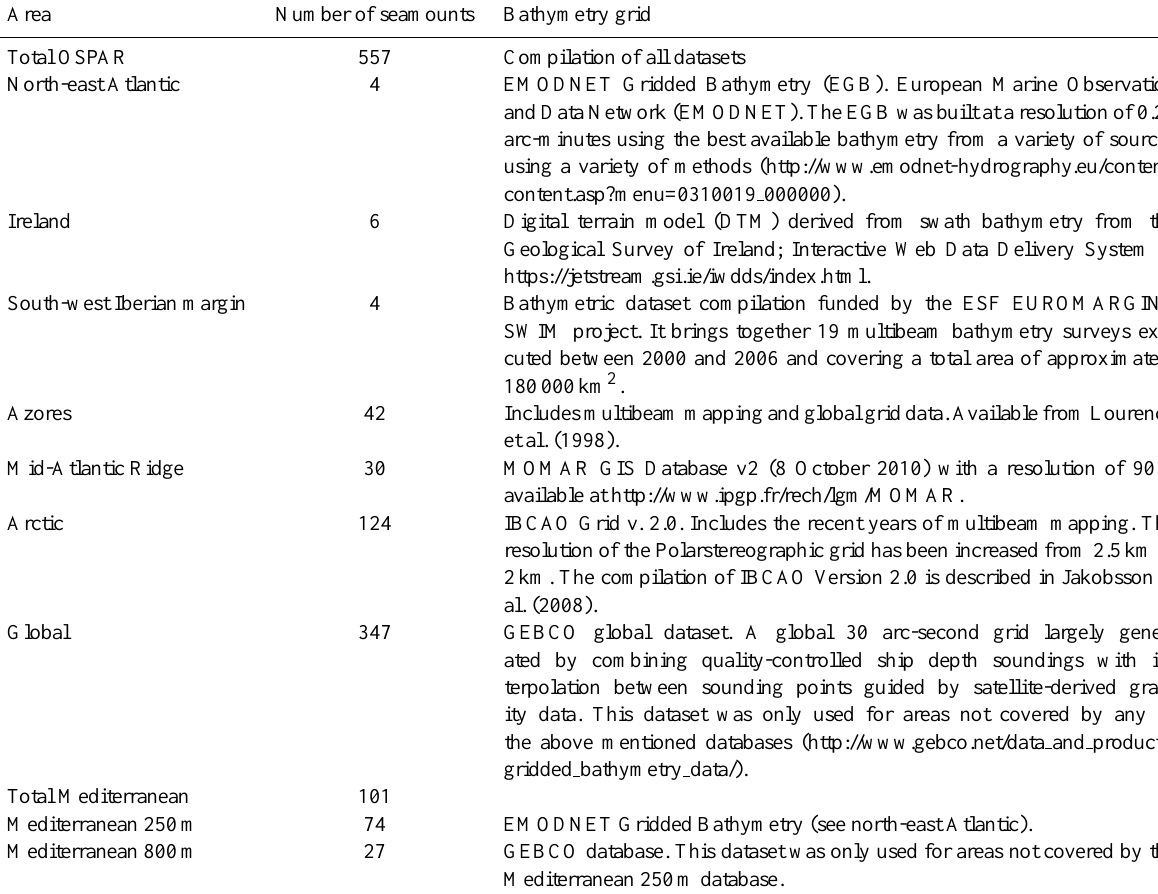
Table 1. Number of seamounts identified by the bathymetry grids used in this study.